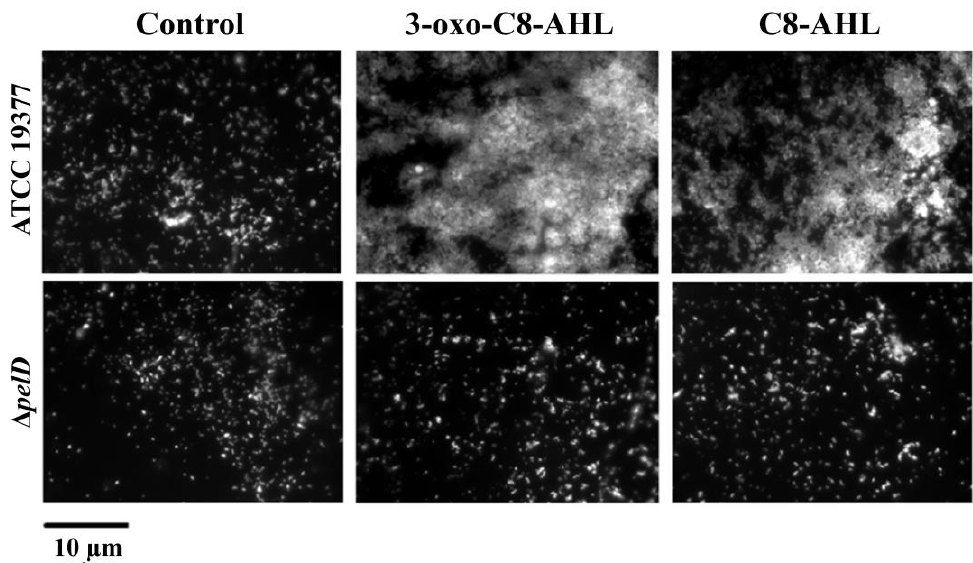
Figure 3. The deletion of pelD interferes with A. thiooxidans biofilm response to both QS signalling molecules 3-oxo-C8-AHL and C8-AHL. S ◦ -coupons were inoculated with A. thiooxidans ATCC 19,377 or mutant derived ∆ pelD strains and extracted from 5-days growth cultures. Then they were washed and stained with 0.01% DAPI. Finally, S ◦ -coupons were viewed by fluorescence microscopy. Size bars represent 10 µ m. Control, DMSO 0.01% without AHL.